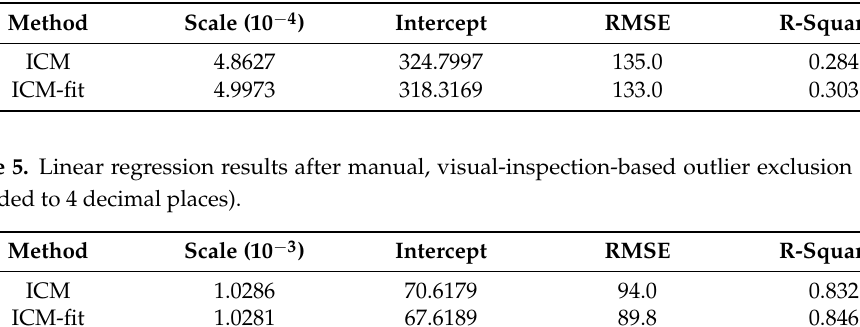
Table 4. Linear regression results (values rounded to 4 decimal places).